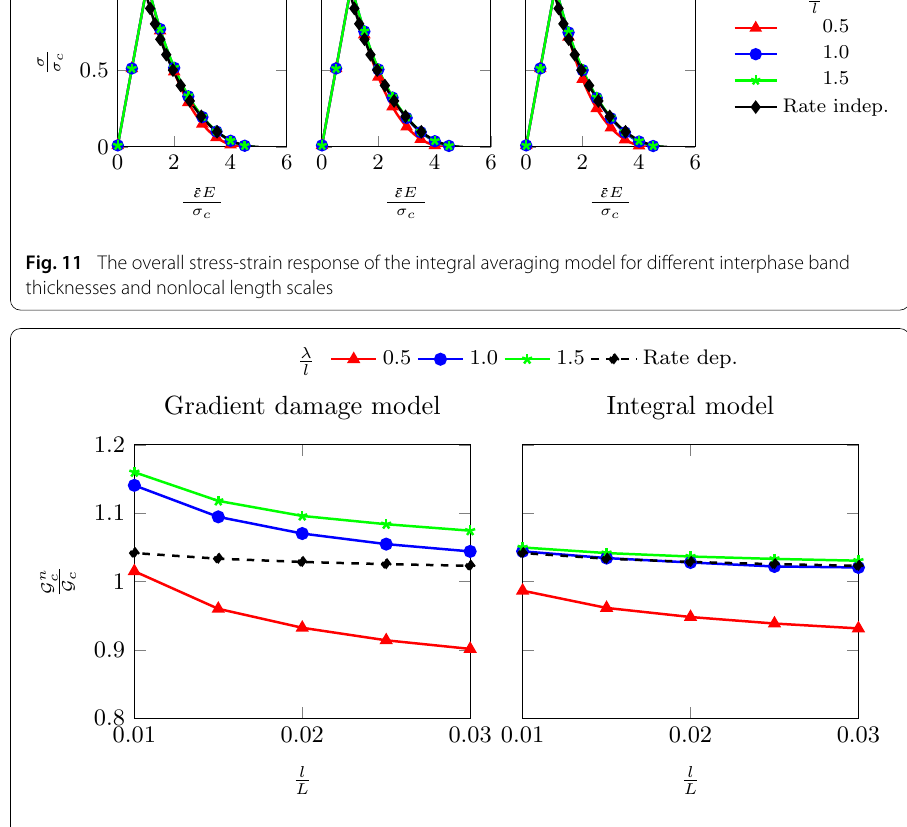
Fig. 12 Performance of the fracture energy calculation G n c / G c for different interphase band thicknesses and nonlocal length